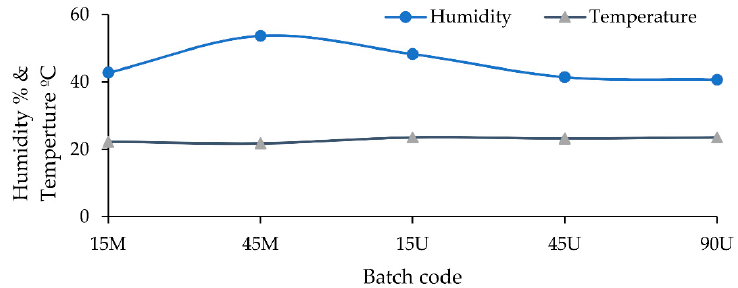
Figure 2. The average recorded humidity and temperature during the experiments.